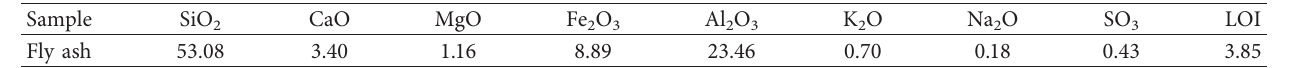
Table 8: The chemical composition of fly ash (%).